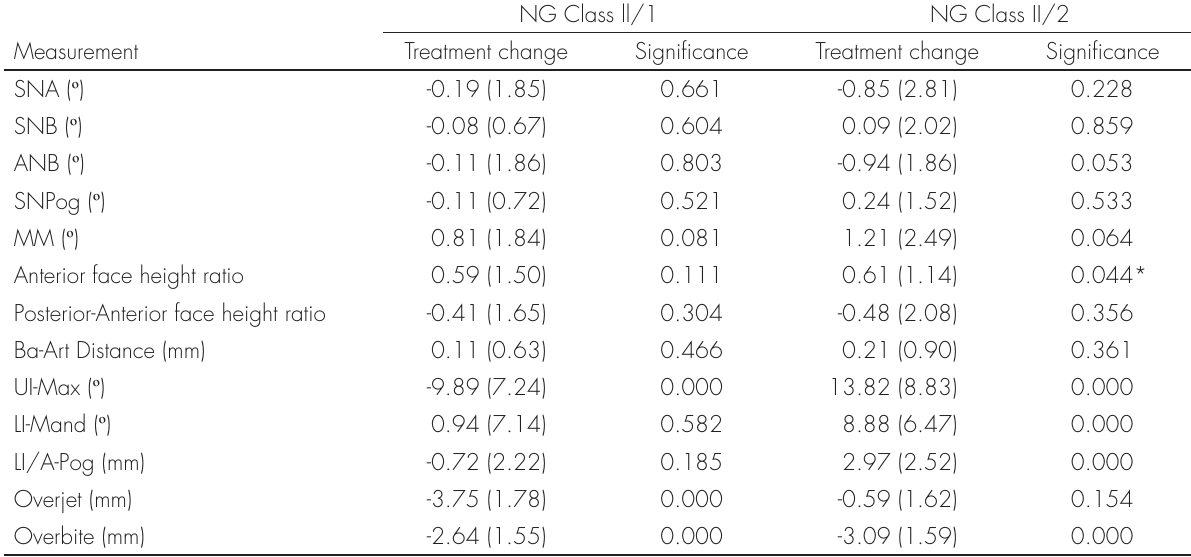
Table V. Changes in cephalometric parameters that occurred during treatment for both non-growing (NG) groups with their statistical